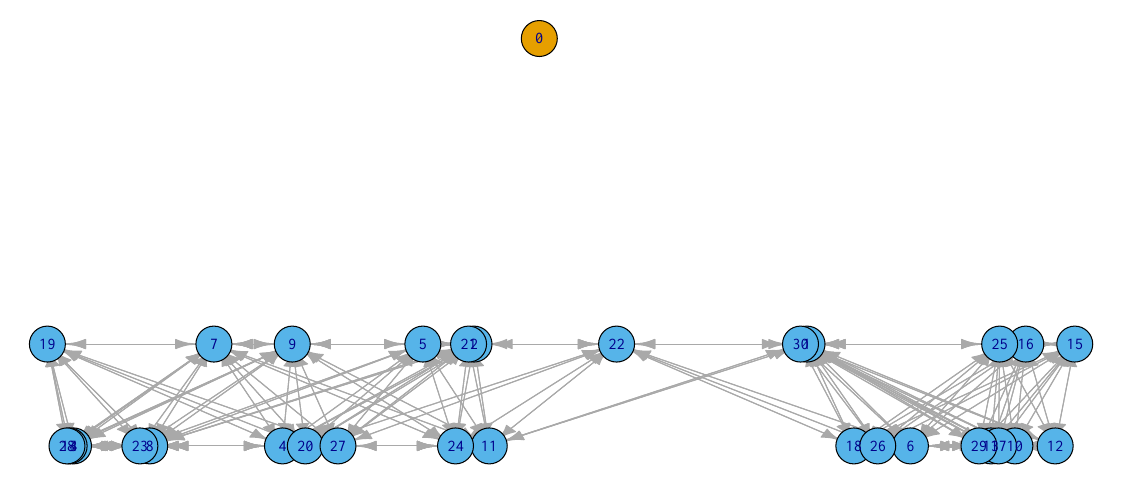
Figure 12. Network topology in Scenario 3 ( node ID 0: BS/AP).